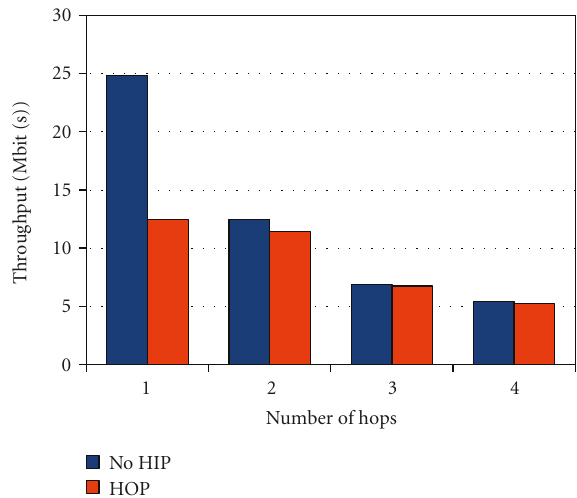
Figure 12: Throughput at di ff erent hop counts in an insecure mode (No HIP) and using